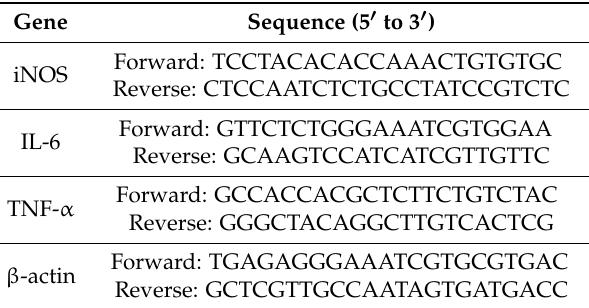
Table 1. Primers used for quantitative real-time